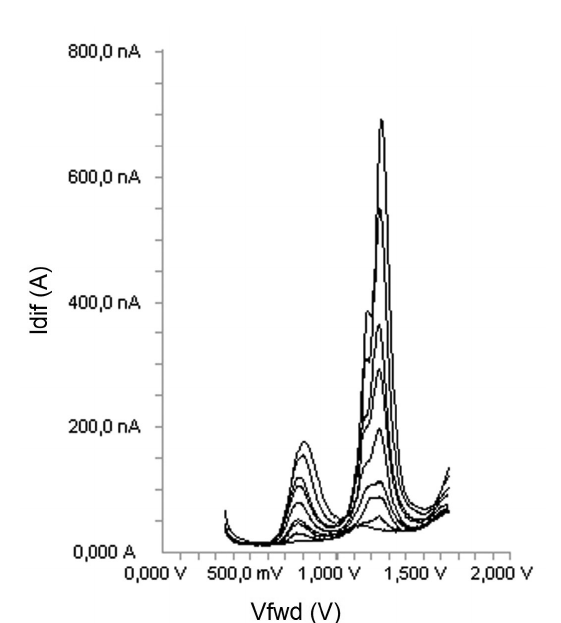
FIGURE 5 - DPV voltammograms obtained for determination in supporting electrolyte (blank, 1.5, 2.5, 5, 7.5, 10, 12.5, 15 and 17.5 µ g mL -1